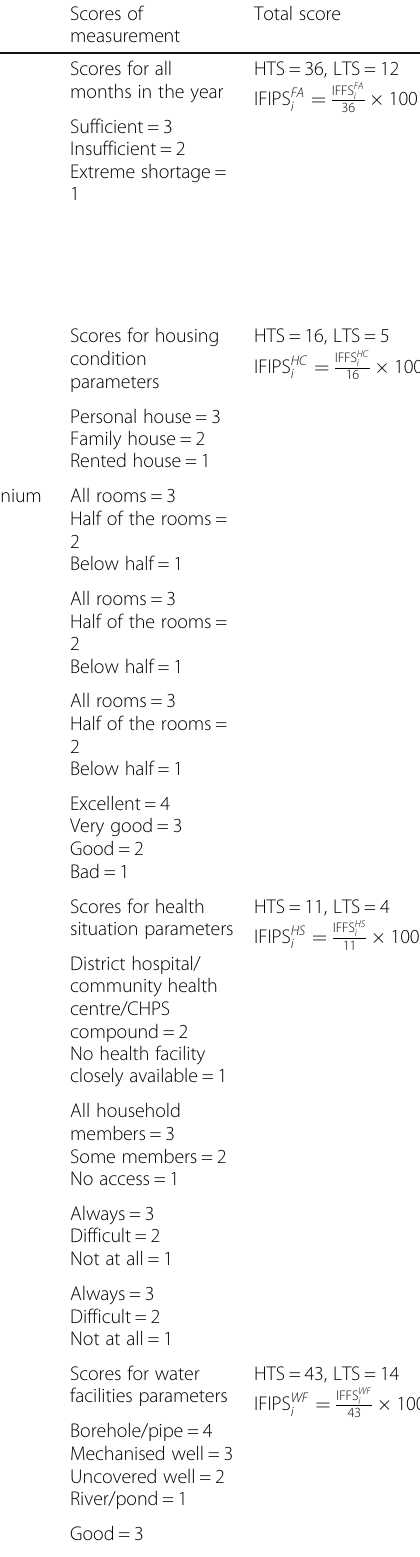
Table 8 Livelihood indicators of farmers and scores of